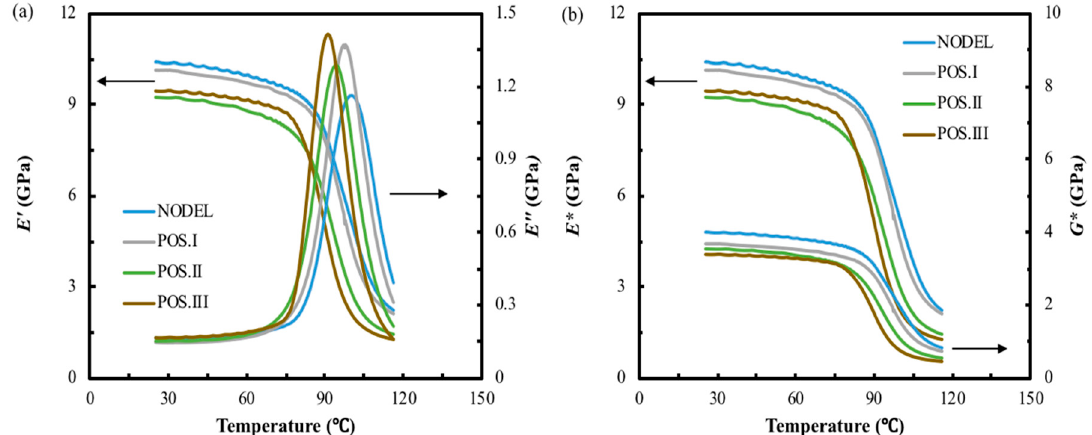
Figure 10. ( a ) Typical storage and lost moduli against temperature curves and ( b ) typical complex storage and shear moduli against temperature curves of FFRP composite with different transverse positions.